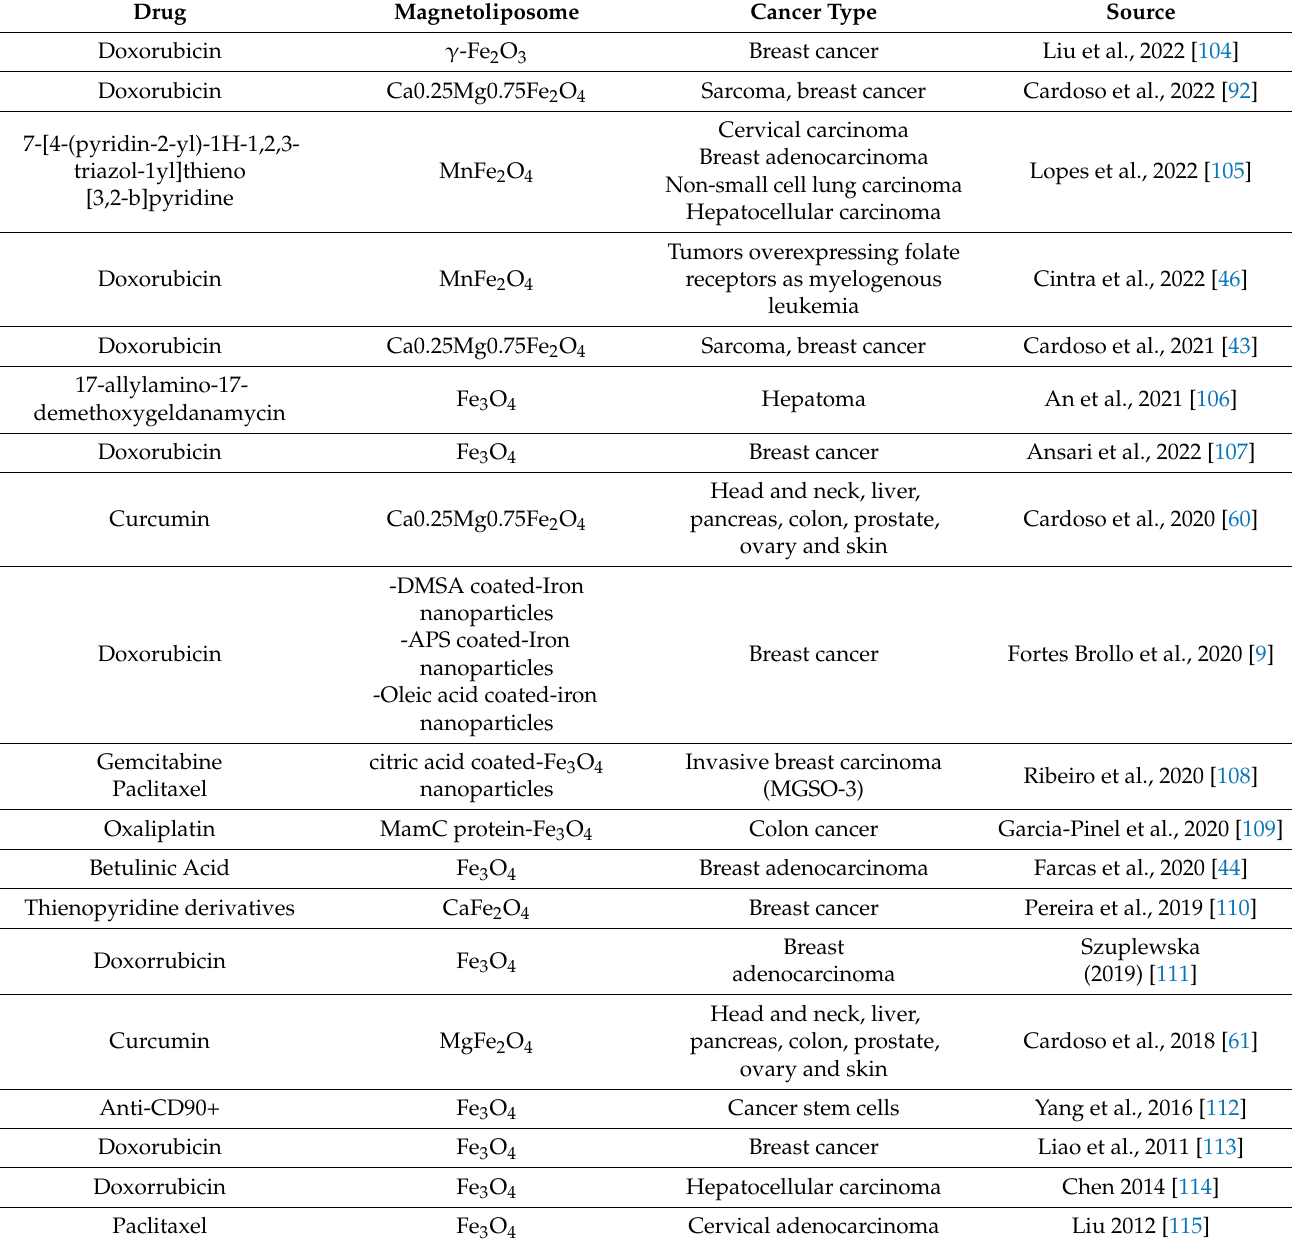
Table 2. In vitro and preclinic assays of magnetoliposomes for cancer